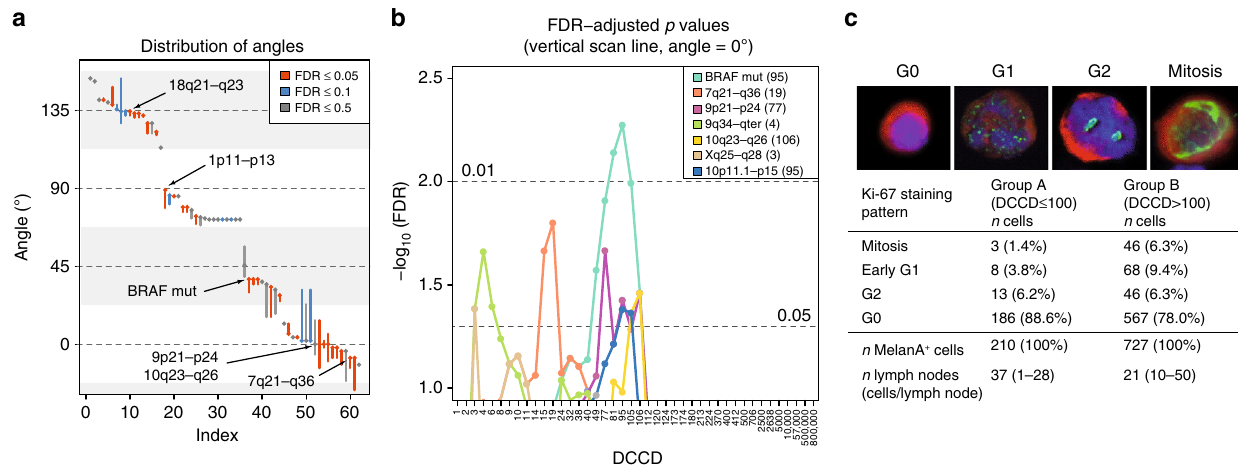
Fig. 7 DCC genetic alterations acquired in the SLN correspond to colonisation. a Distribution of best classi fi er angles for different loci/mutations. These can be grouped according to the prototypic categories in a , d , g and j . Vertical bars correspond to the range of angles associated with the same minimal FDR value, diamonds indicate angles that are closest to the ideal prototypes. Only the 62/82 loci/mutions with at least 10 samples per class were included. b DCCD-dependence of genomic changes derived using a vertical classi fi er (angle = 0°) positioned according to the experimentally measured values (set points left of these values). Only category 3 and 4 loci whose FDR values fall below 0.05 are shown. Numbers in brackets following the legend (e.g. BRAF mut (95)) indicate peak DCCD. c Proliferation of DCCs in sentinel nodes. Immuno fl uorescence of Melan A + cells in G0-, G1-, G2-phase and mitosis (from left to right). Nucleus (blue), Melan A (red), Ki-67 (green; for n , see fi gure; Fisher ’ s exact test, p = 0.0005 for G0 vs .